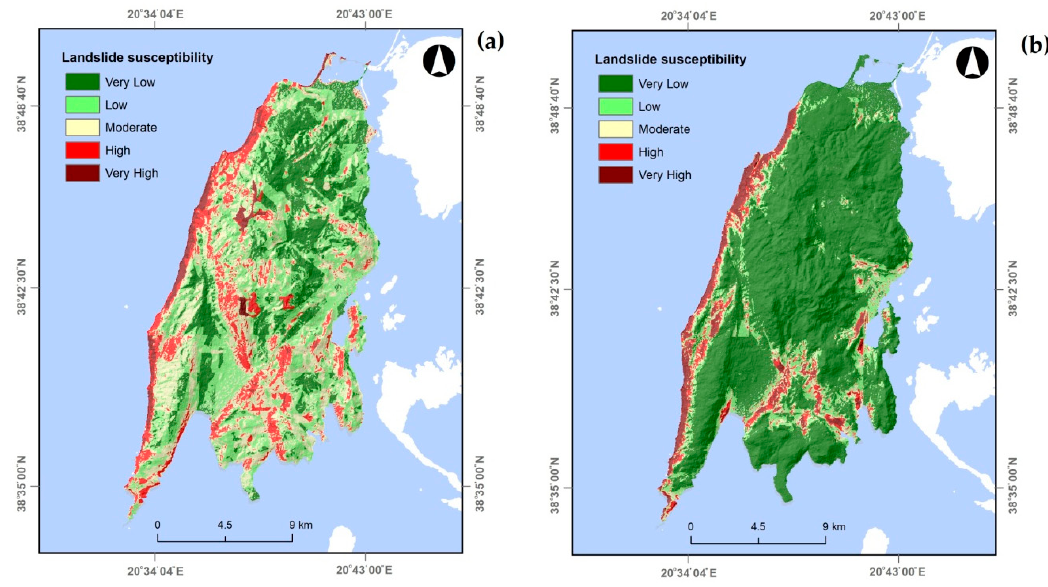
Figure 3. Landslide susceptibility map produced by: ( a ) FR model; ( b ) LR model.